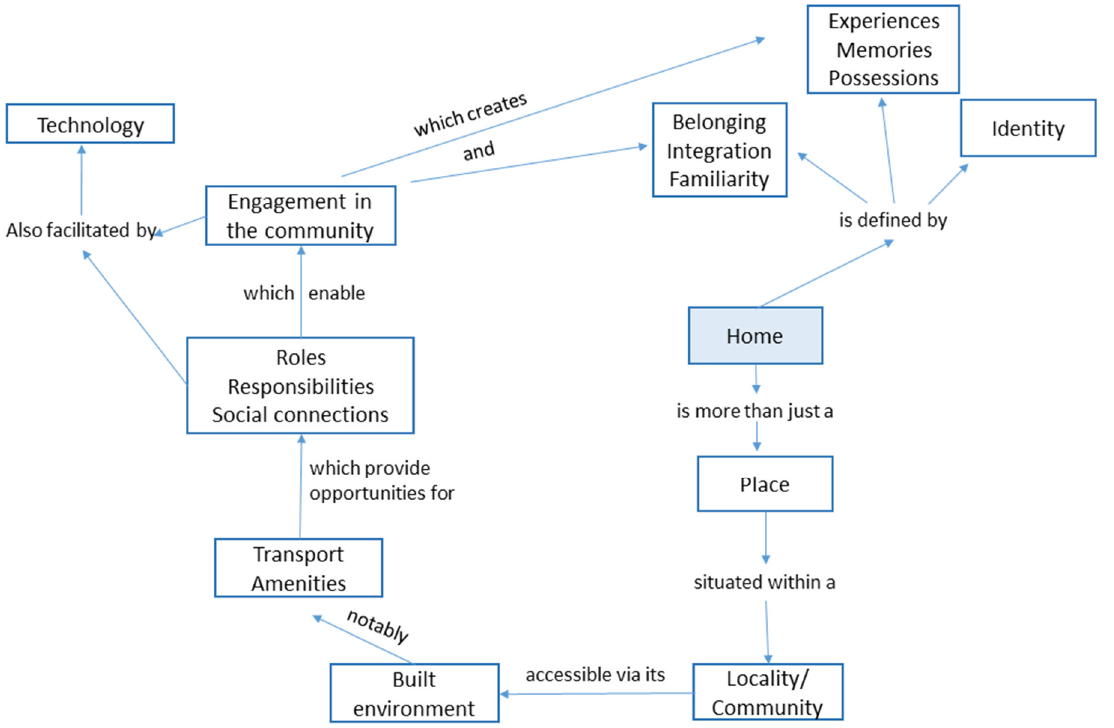
Figure 1. Conceptual framework illustrating the interactions between the notions of home, place, the built environment, integration, interactions with the community, and the use of technology.